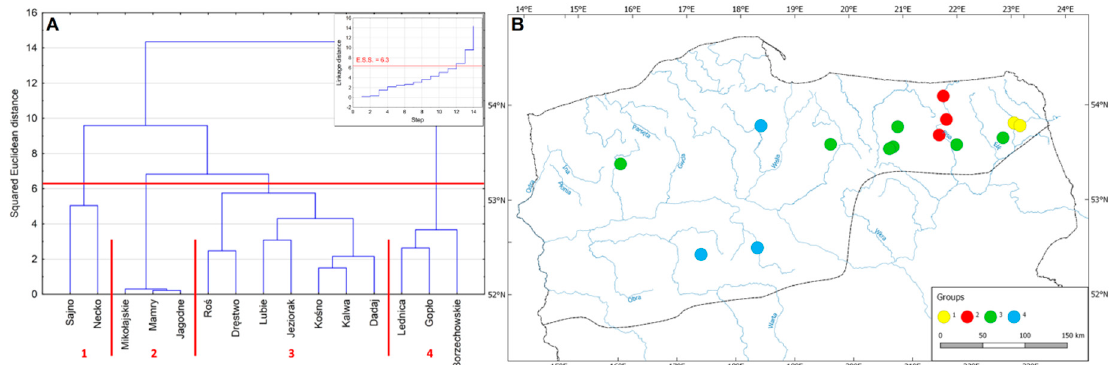
Figure 8. Dendrogram of grouping lakes by values of correlation coefficients of monthly SCAND indices with monthly water levels and the plot of the linkage distance ( A ); Spatial distribution of lakes in the performed grouping ( B ).